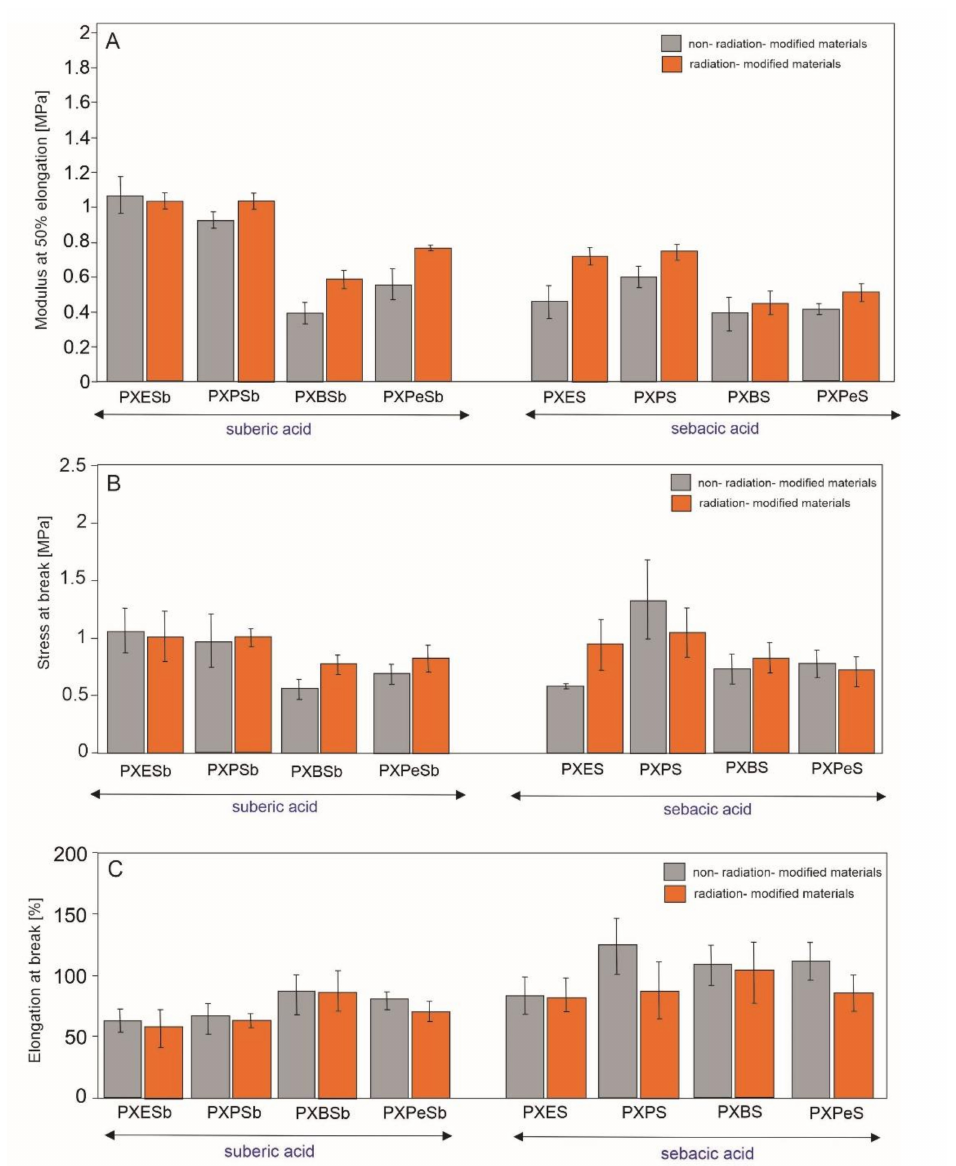
Figure 12. Mechanical properties of PXESb, PXPSb, PXBSb, PXPeSu and PXES, PXPS, PXBS, PXPeS non-radiation-modified materials (gray) and radiation-modified materials (orange): tangent modulus at 50% elongation ( A ), stress at break ( B ), and elongation at break ( C